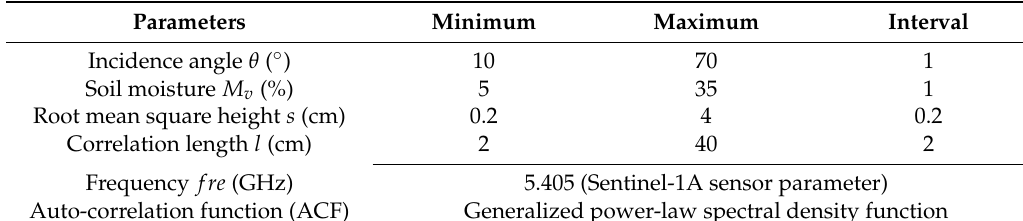
Table 2. Parameter setting of AIEM.